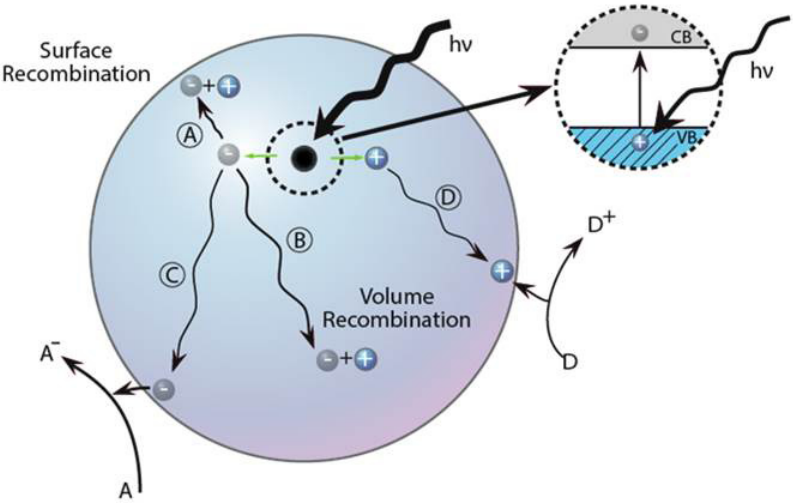
Figure 1. Electron/hole kinetics during water splitting reactions. The photogenerated carriers can recombine at a surface trap (A) or in the bulk (B); alternatively, they can interact with acceptor (C) or donor (D) species. Reprinted (adapted) with permission from (Linsebigler, A.L., Lu, G., and Yates Jr, J.T., 1995. Chemical Reviews, 95(3), pp. 735–758). Copyright ©1995, American Chemical Society. Ref [41].